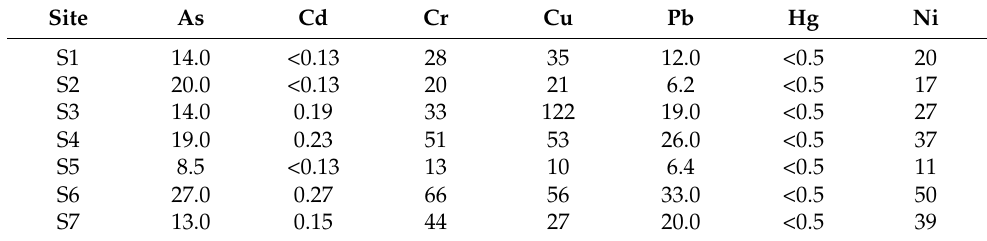
Table 5. Heavy metal concentrations (mg/kg) in the sediments of Bogdanas River in November